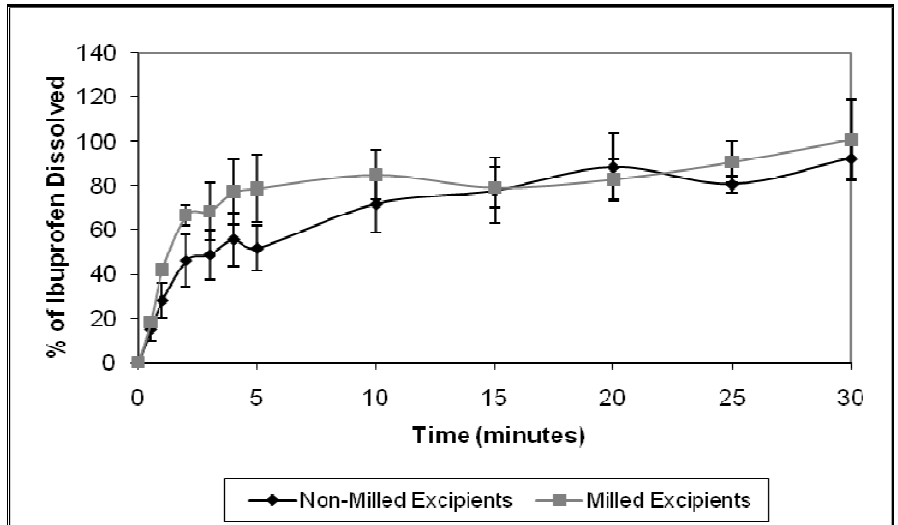
Figure 7. Dissolution profile of ibuprofen from lyophilized ODTs, prepared from non- milled and milled tablet excipients (mean ± S.E., n =